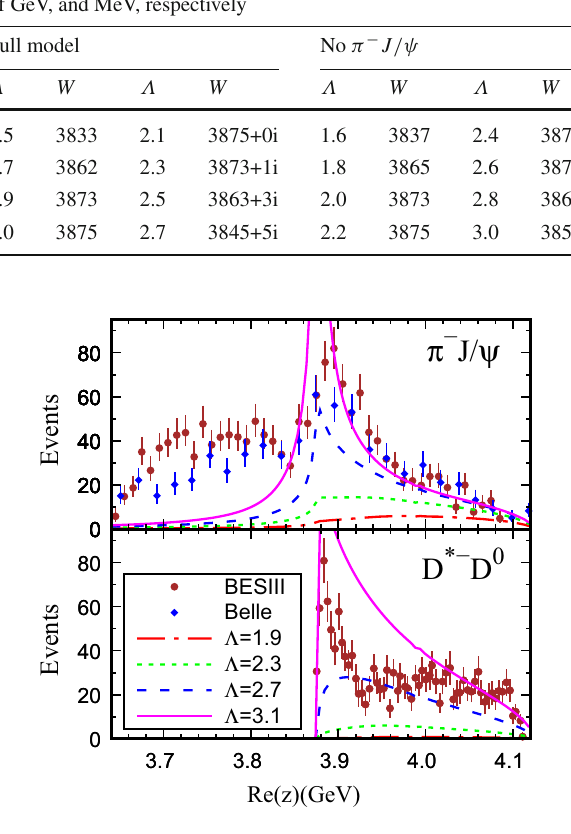
Fig. 4 Theinvariantmassspectraobtainedonlywithcouplingbetween J /ψπ − channel and D ∗− D 0 − D − D ∗ 0